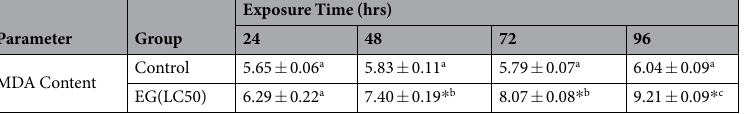
Table 7 revealed the genotoxic effect of fungal extract following treatment with ethyl acetate extract of S. commune at different hours of exposure using comet assay. The parameters used to assess genotoxicity were Percent Tail DNA and Olive Tail Moment (OTM).The nuclei with a clear tail like extension were observed after treatment indicating that the cells of insect